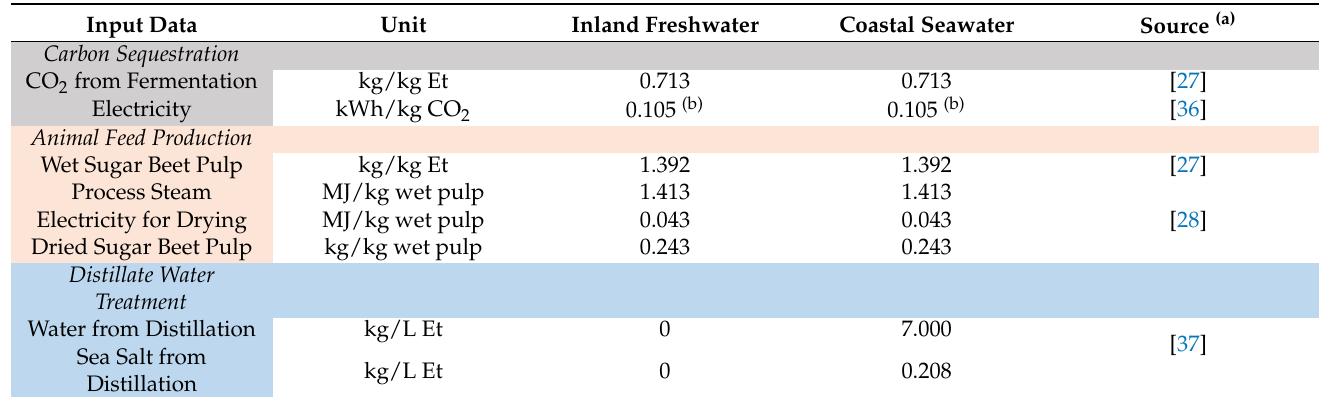
Table 3. Life cycle inventory for the processing of